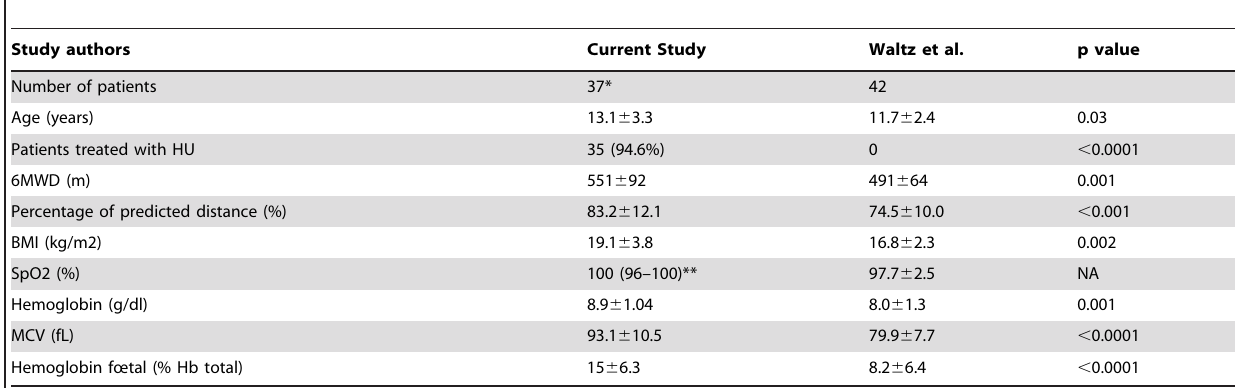
Table 3. Comparison of baseline characteristics and clinical data from Brussels and Waltz series; all values represent mean 6 SD unless otherwise